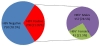
HBV positive patients demographic characteristics.